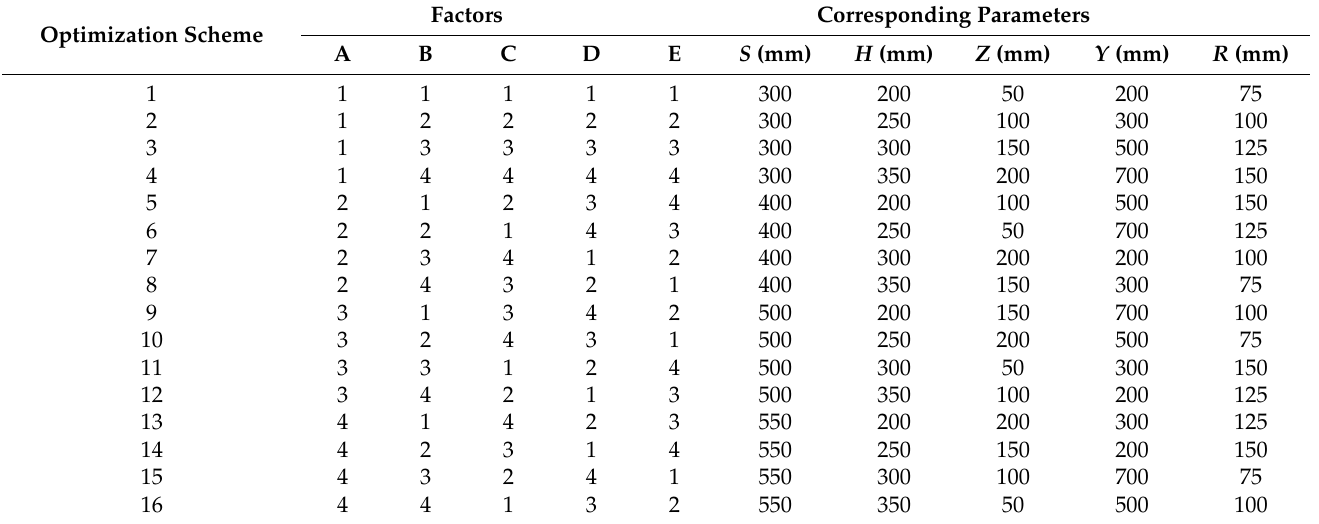
Table 3. Table of orthogonal optimization scheme.